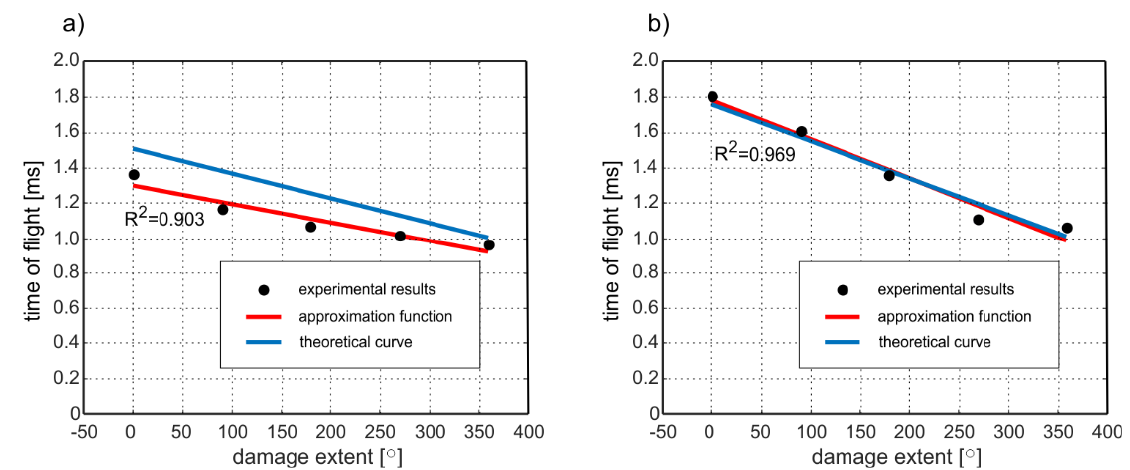
Figure 10. Times of flight of reflections registered at the end of the beams for excitation frequency of ( a ) 40 kHz and ( b ) 50 kHz for variable extent of debonding.